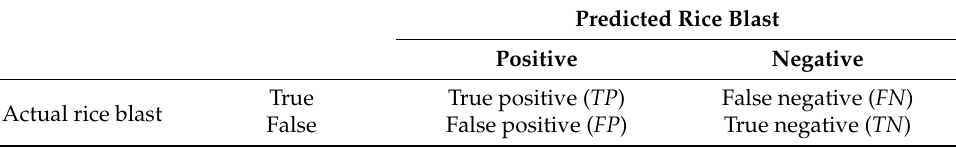
Table 3. Illustration of the confusion